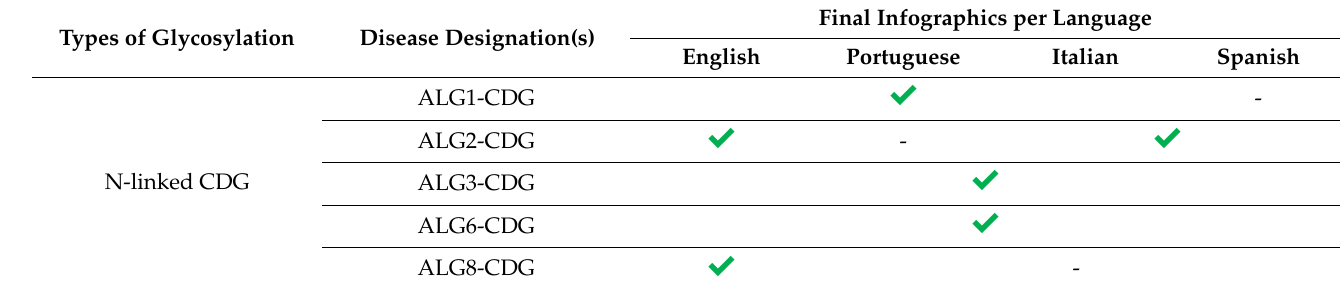
Table 3. Finished CDG infographics by different types of glycosylation. Types of